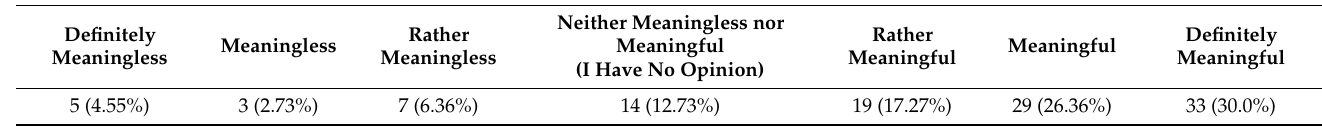
Table 6. The degree of affirmation/negation of hope in the cognitive aspect in relation to the pair of adjectives meaningless–meaningful expressed by men in the terminal stage of cancer ( n = 110).